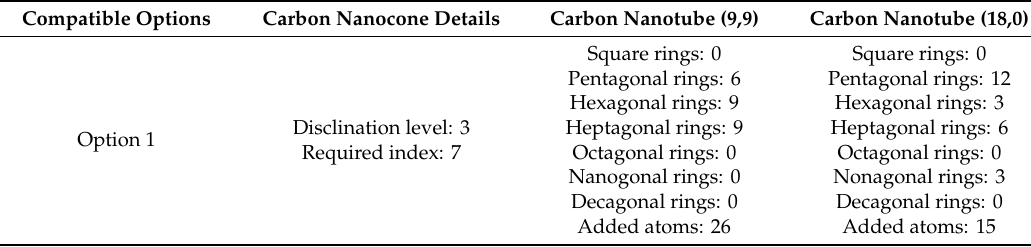
Table 5. Rings formed in the junction between carbon nanotube and the carbon nanocone. Compatible Options